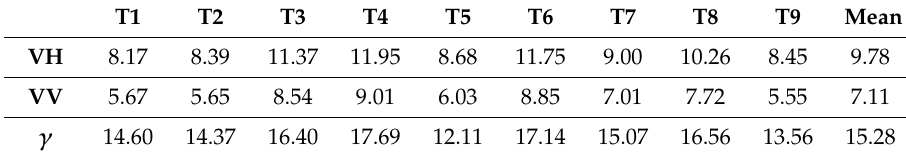
Figure 1. ( a ) VH amplitude; ( b ) VV amplitude; ( c ) pseudo color; ( d ) reflection symmetry. Table 1. Signal-to-clutter ratios (SCRs) (unit: dB) of the nine ship targets in Figure 1. T1